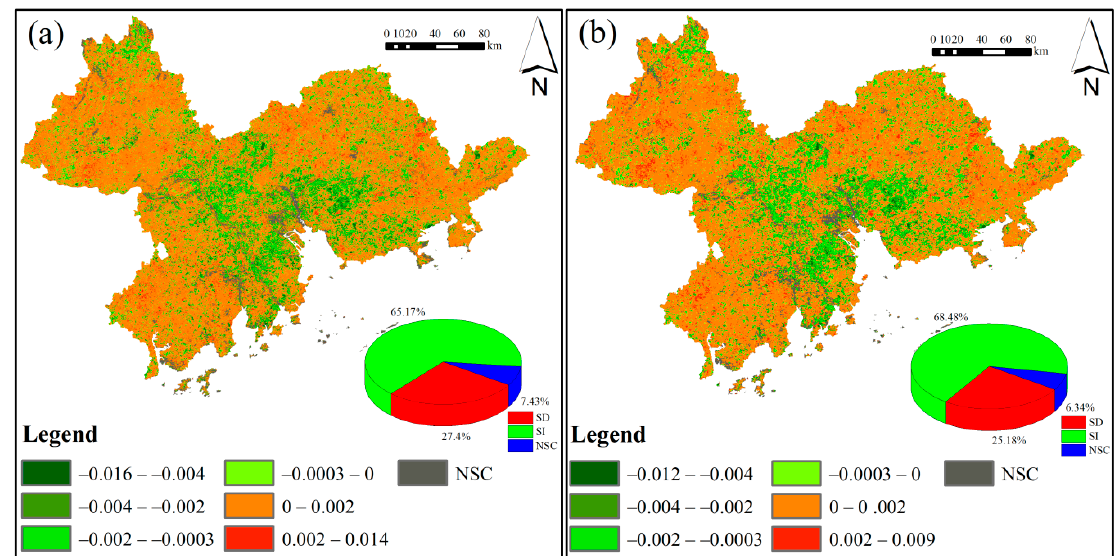
Figure 10. Comparison of Q1-CTR and A1-CTR in the PRD: ( a ) Q1-CTR; and ( b ) result of A1-CTR; SD indicates significant decrease, SI indicates significant increase, NSC indicates no significant change.